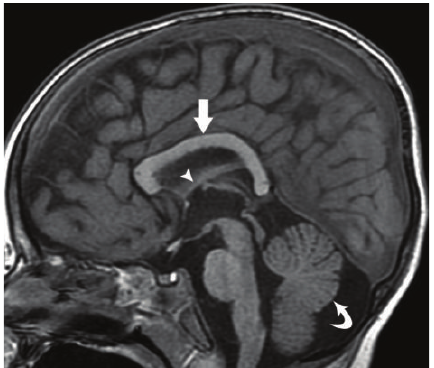
Figure 1: Sagittal SPGR T1WI (repetition time msec/echo time msec/inversion time msec, 11/5/500) showing a relatively featureless, mildly dysgenetic corpus callosum of uniform thickness (straight arrow), small fornices consistent with hypoplasia (arrowhead), and mild generalized vermian hypoplasia (curved arrow). Note normal pituitary gland.